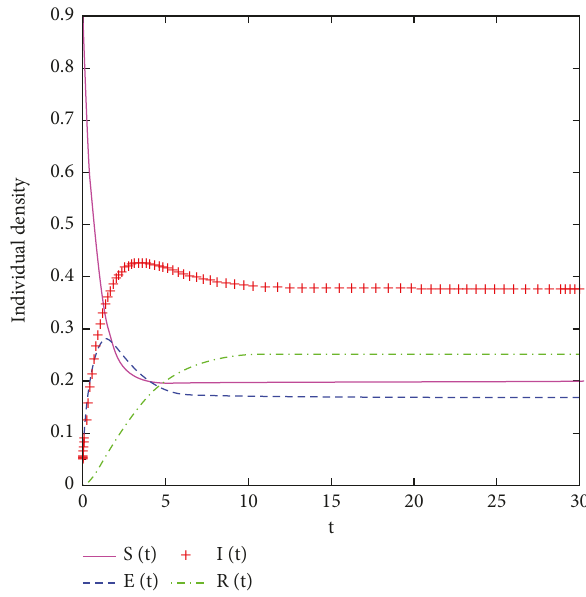
Figure 2: Simulation result of risk contagion in the case of R 0 >